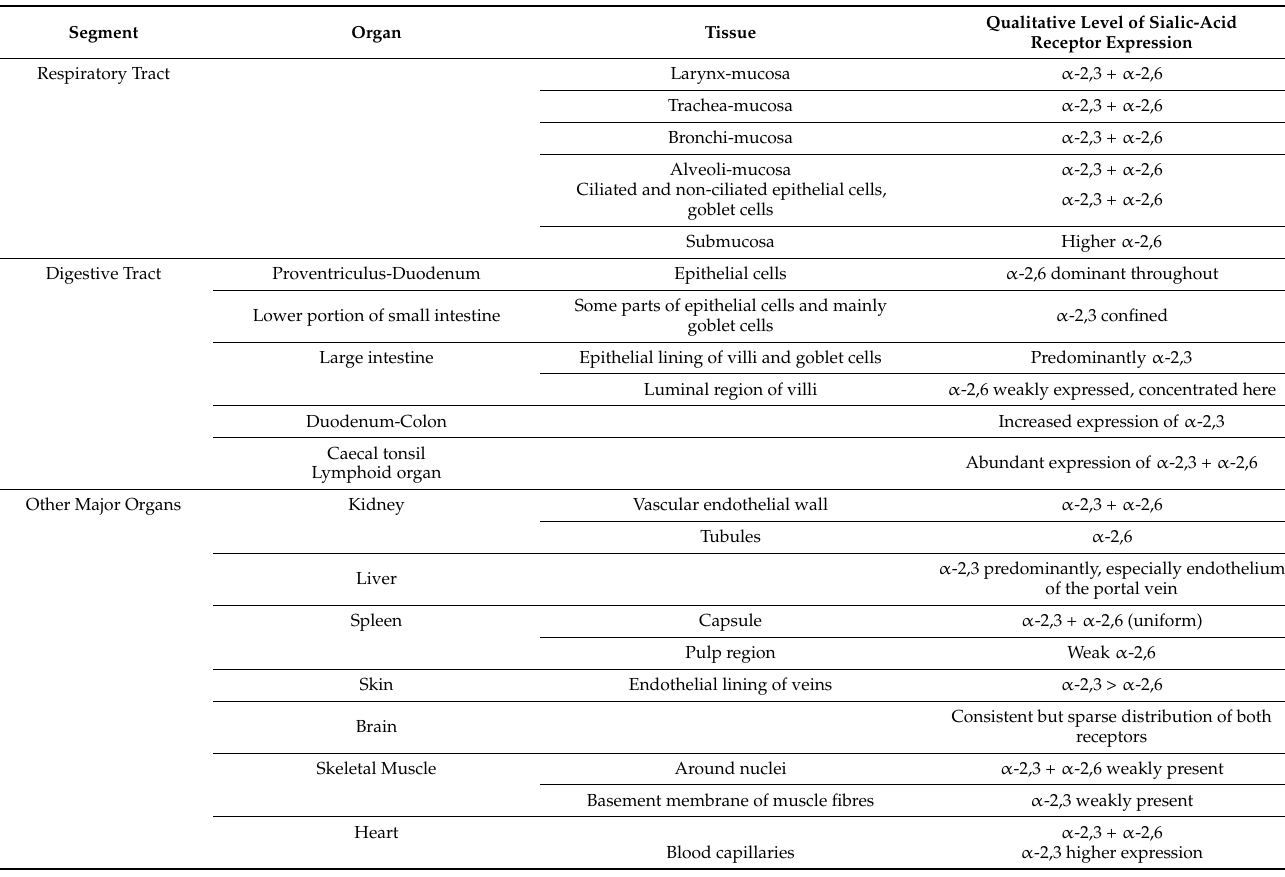
Table 3. Distribution of α -2,3 and α -2,6 sialic acid receptors within organs and tissues of Dromaius novaehollandiae .